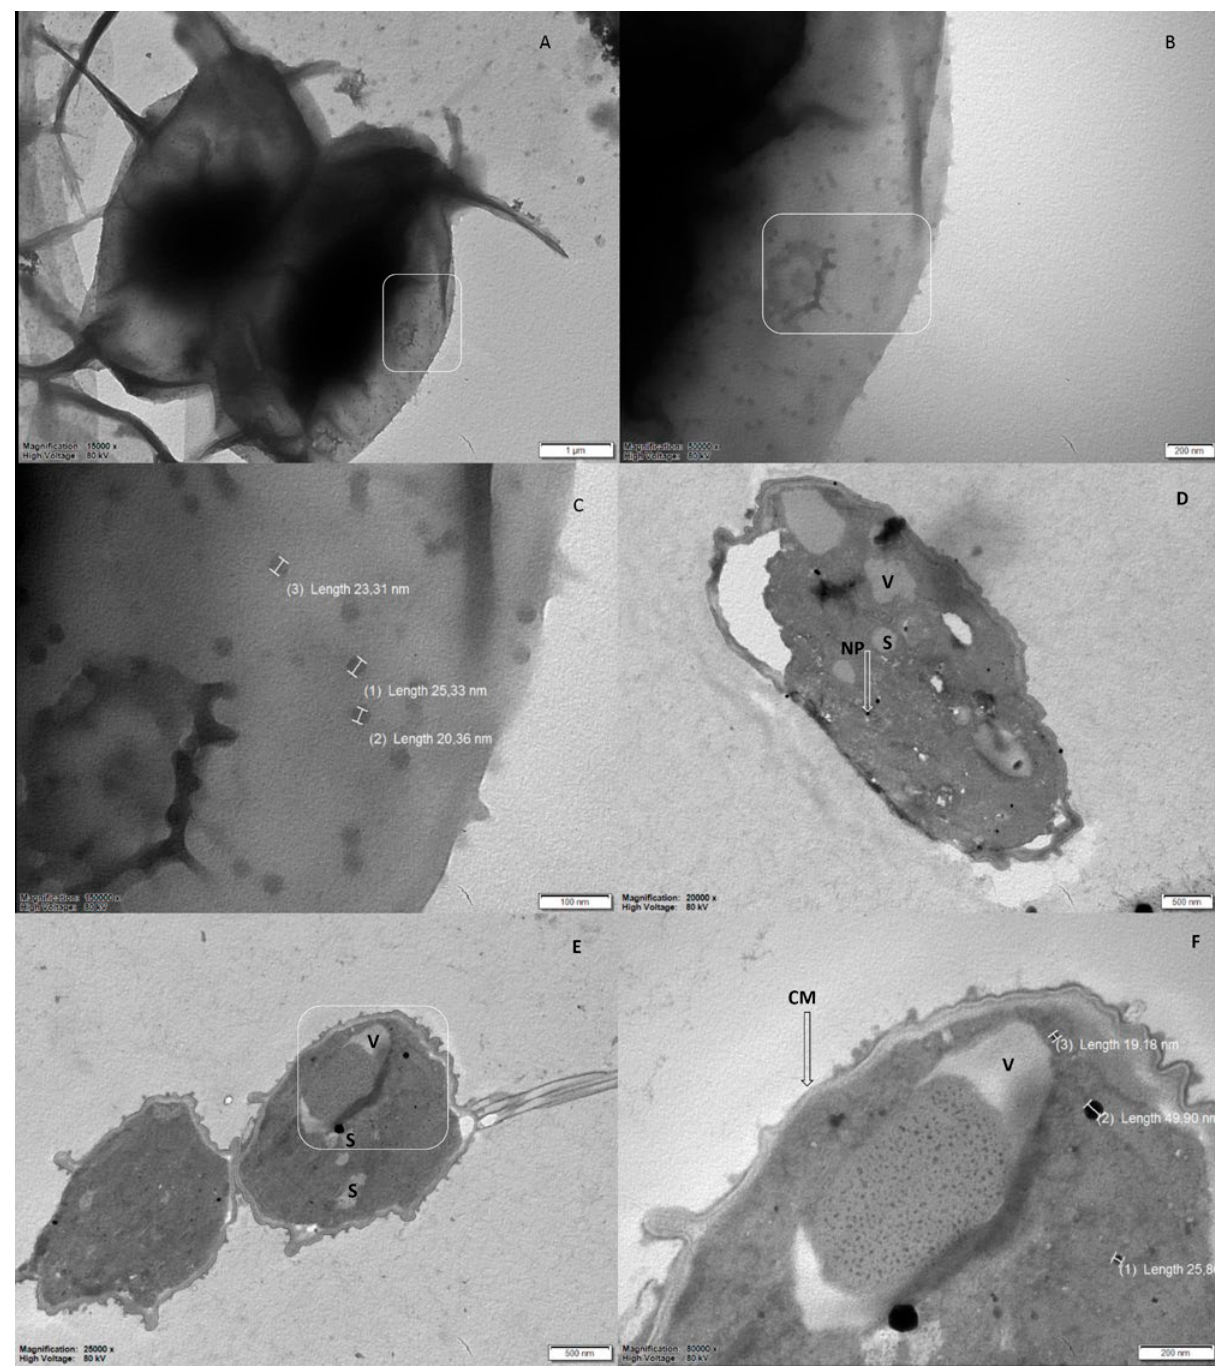
Fig. 2. Morphological characterization of the silver nanoparticles. A, B, C Intracellular synthesis, TEM Image of Desmodesmus sp. cell medi- ated synthesized silver nanoparticles. D, E, F Cellular localization of in Intracellular silver nanoparticles, TEM micrograph of thin section (~ 60 nm). NP:nanoparticle, S starch, V vakuol, CM Cytoplasmic